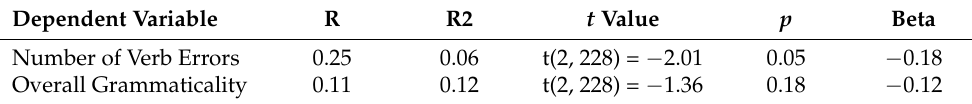
Table 7. Summary of Regression Results for Predictor Variables of Writing